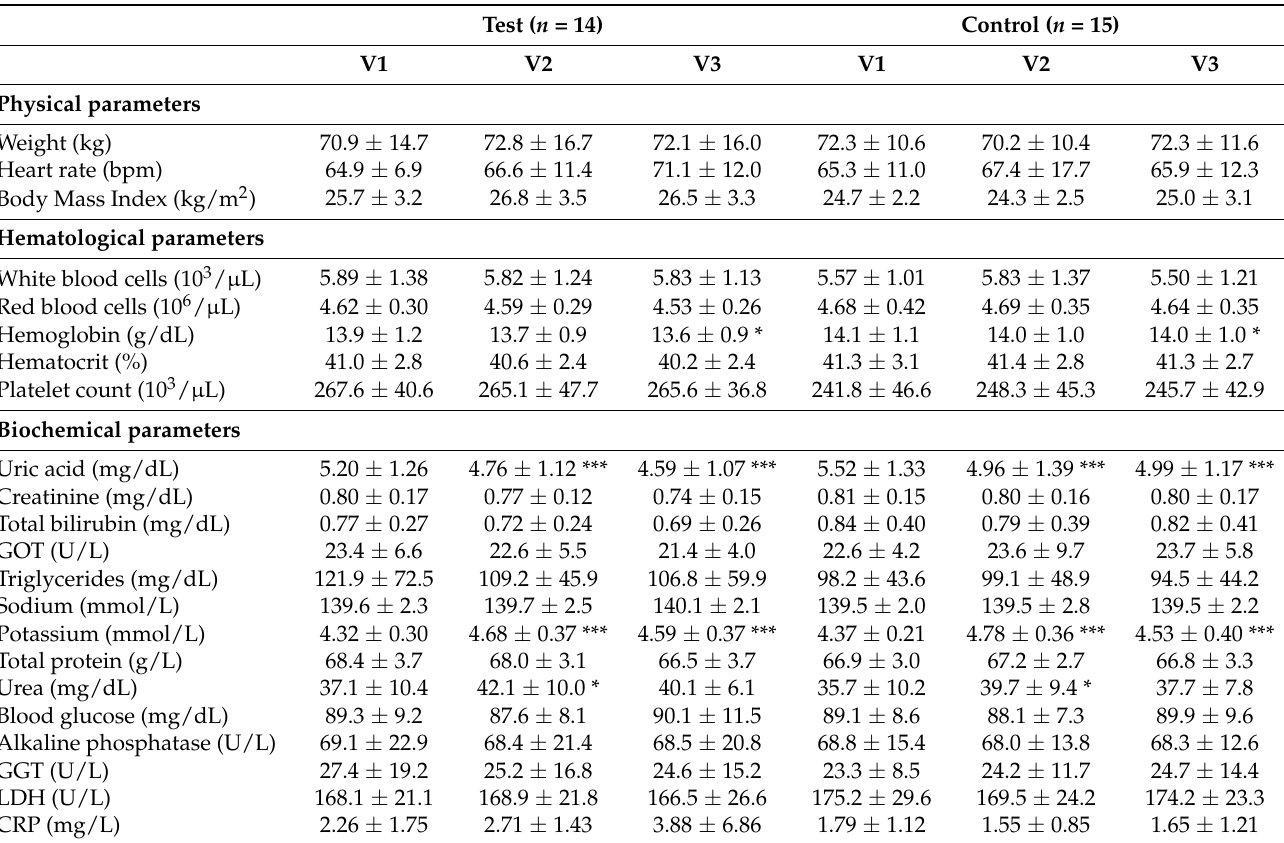
Table 2. Physical, hematological, and biochemical